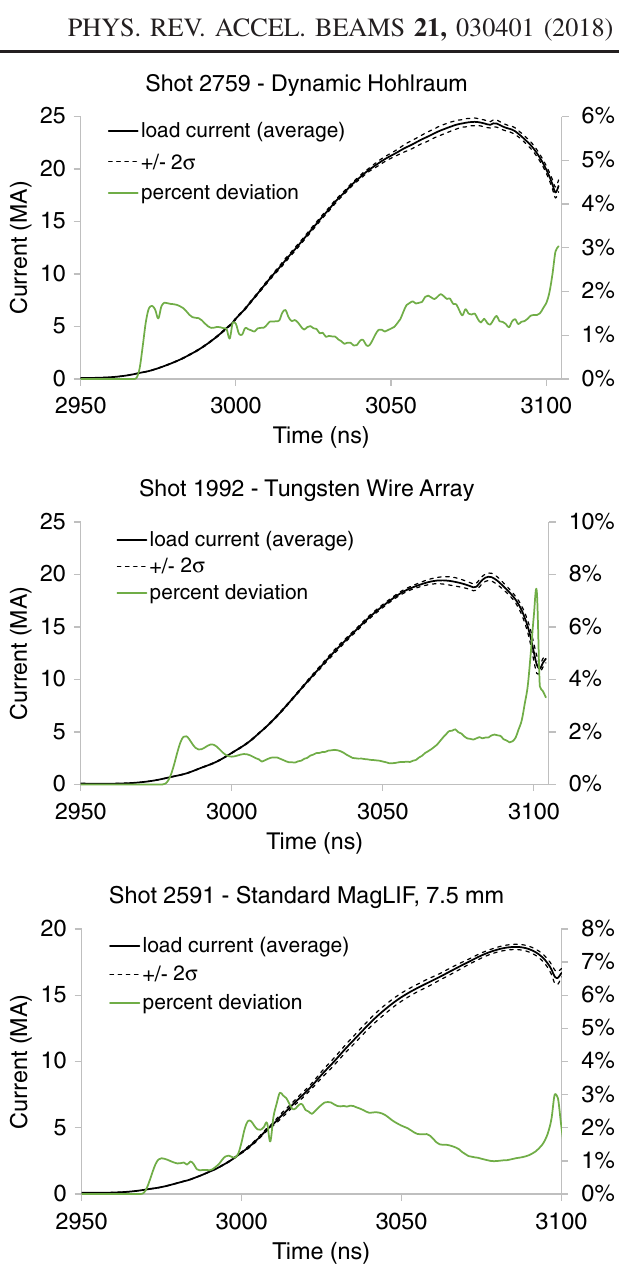
FIG. 3. Representation of the random error in the load current due to the swarm optimization process. Each figure shows the averageloadcurrentwith þ = − 2 σ boundsandthepercentdeviation ( 2 σ ) using the results from 20 swarm optimization